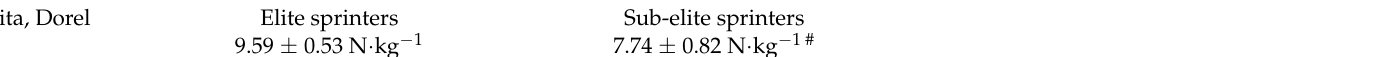
from descending from descending significantly greater significantly greater compared with compared with either leg in the either leg in the block phase). block phase).